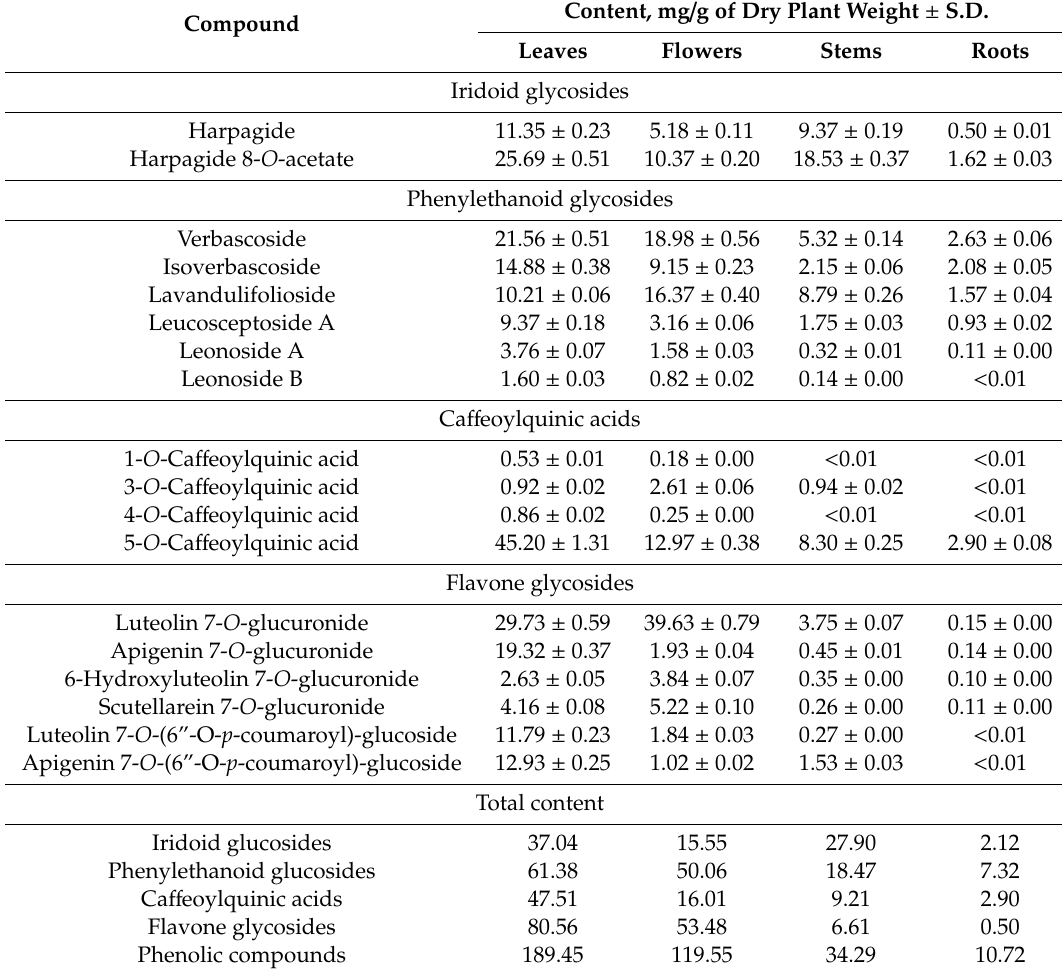
Table 3. Content of selected compounds in G. bifida